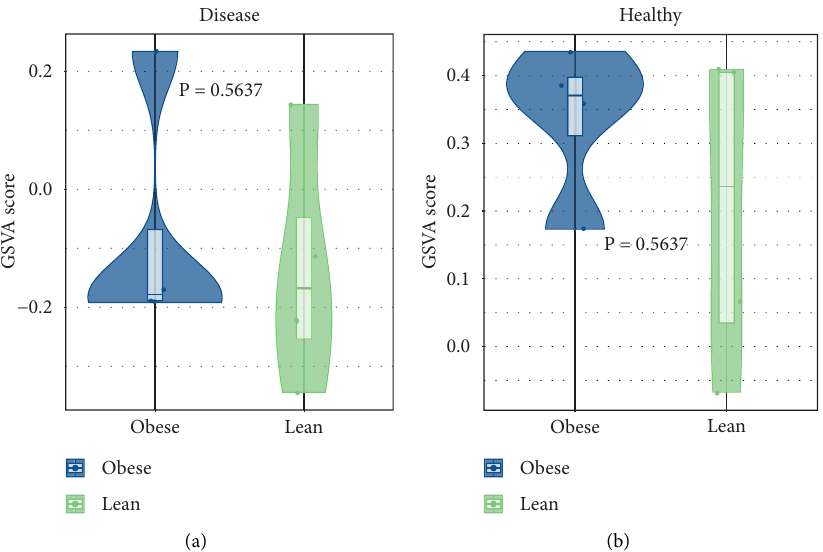
Figure 2: Comparison of the GSVA enrichment score of the linoleic acid metabolism pathway between obese and lean samples in the disease group (a) and the healthy group